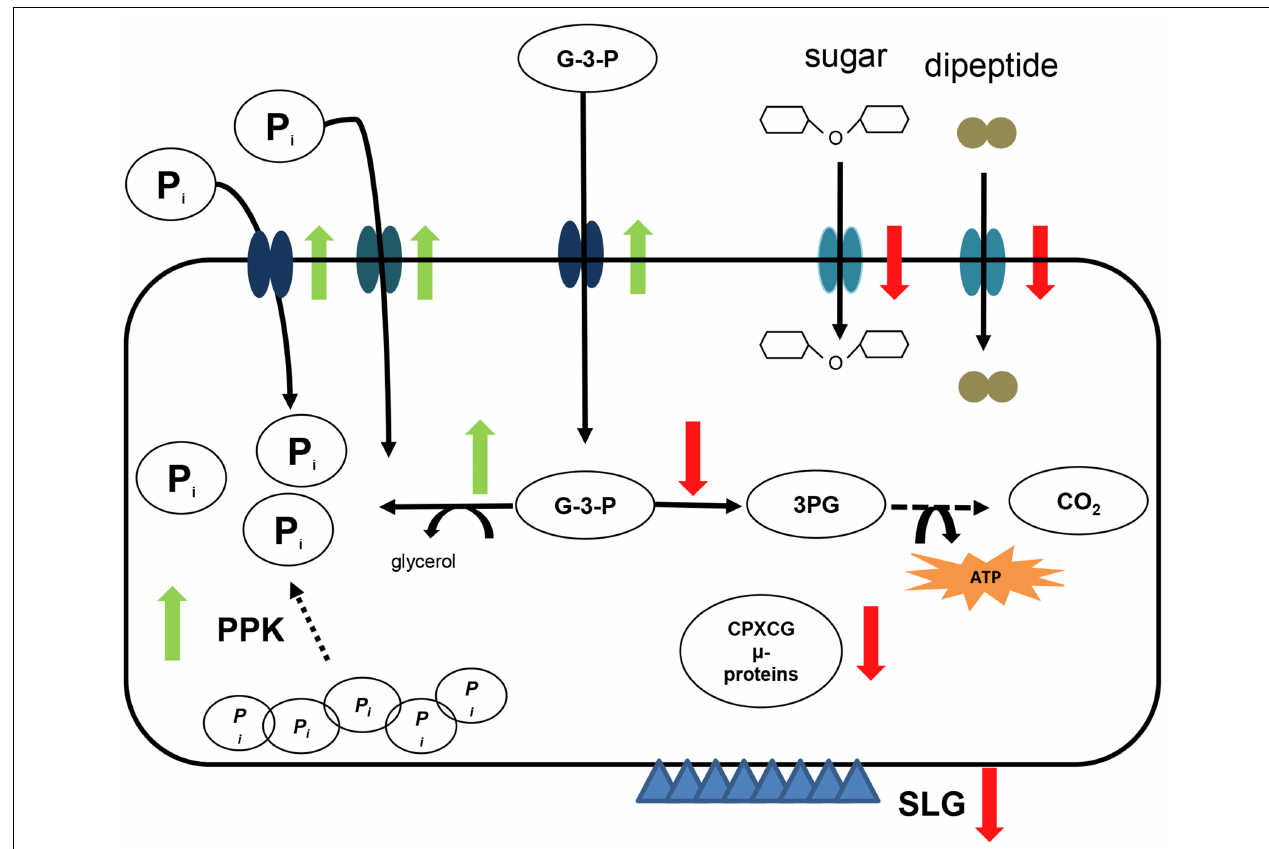
FIGURE 11 | Schematic overview of the sRNA132 regulon. Selected members of the sRNA132 regulon are shown schematically and the positive or negative regulation by sRNA132 is indicated by green upward and red downward arrows, respectively. The following abbreviations are used: P i – orthophosphate, G-3-P